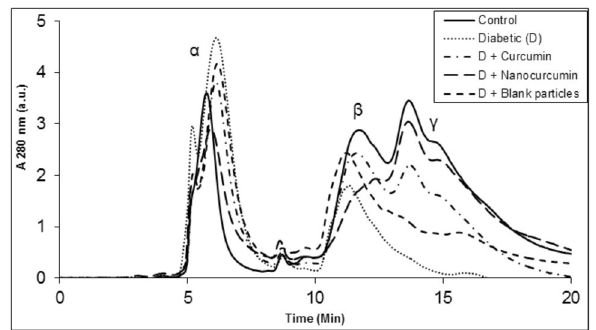
Figure 5. The effect of curcumin and nanocurcumin on crystallin distribution in the soluble protein fraction of rat lens. Soluble protein was loaded on TSK-G3000 SWXL gel filtration HPLC column and protein peaks were detected at 280 nm. Peaks representing α-, β- and γ- crystallins are indicated at their respective positions.